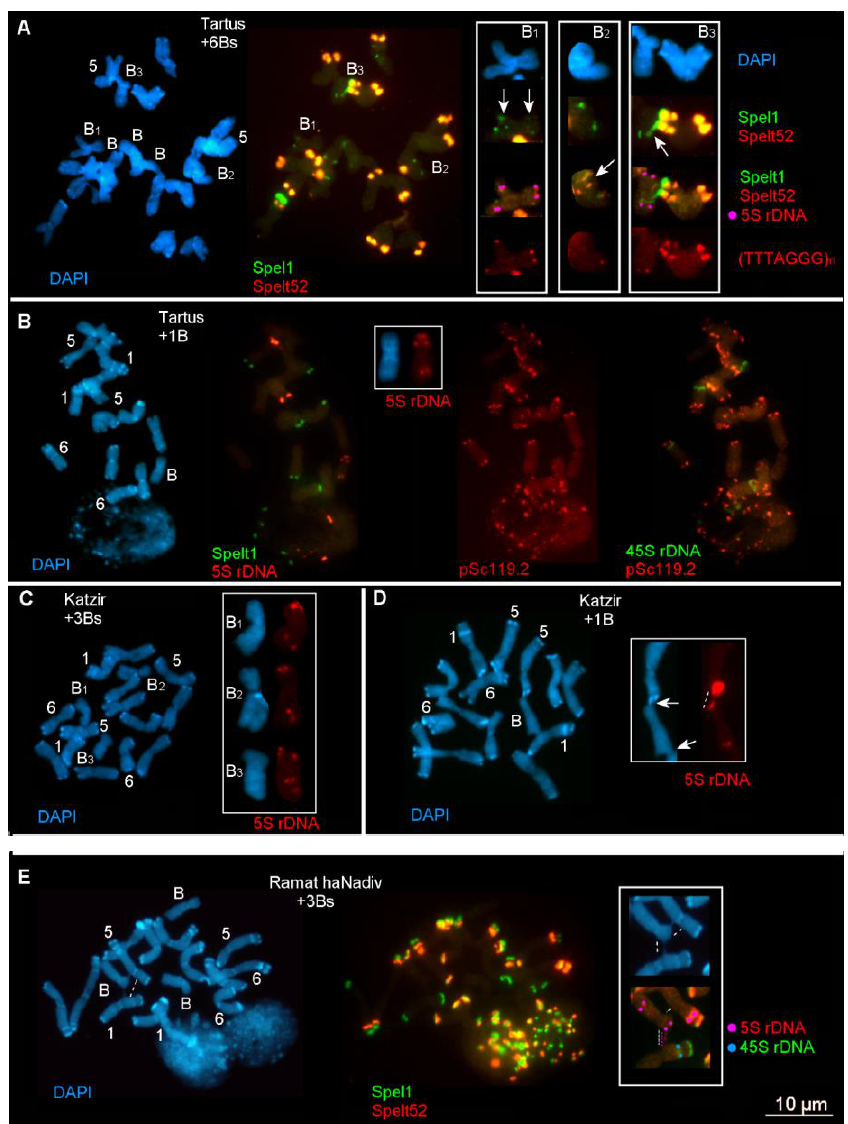
Figure 2. Rearrangements of B chromosomes and ectopic B-A chromosome associations in somatic cells in different genotypes of Aegilops speltoides . Fluorescence in situ hybridization (FISH) analysis was conducted on somatic chromosomes of plants from the populations of Tartus ( A,B ) , Katzir ( C , D ), and Ramat haNadiv ( E ) . DNA probes for FISH: Spelt1 (in green), Spelt52 (in red), pSc119.2 (in red), 5S rDNA (in red), 45S rDNA (in green), and (TTTAGGG) n (in red); differential staining with DAPI (in blue). Only chromosomes 1, 5, 6, and B are numbered. (A) Somatic chromosomes of the plant from Tartus (2 n = 2x = 14 + 6B). A single pair of A chromosomes carries a large Spelt1 cluster. One